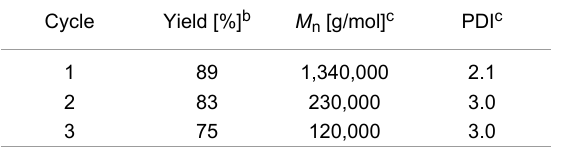
Table 3: ROMP of M1 under biphasic conditions with recycling. a